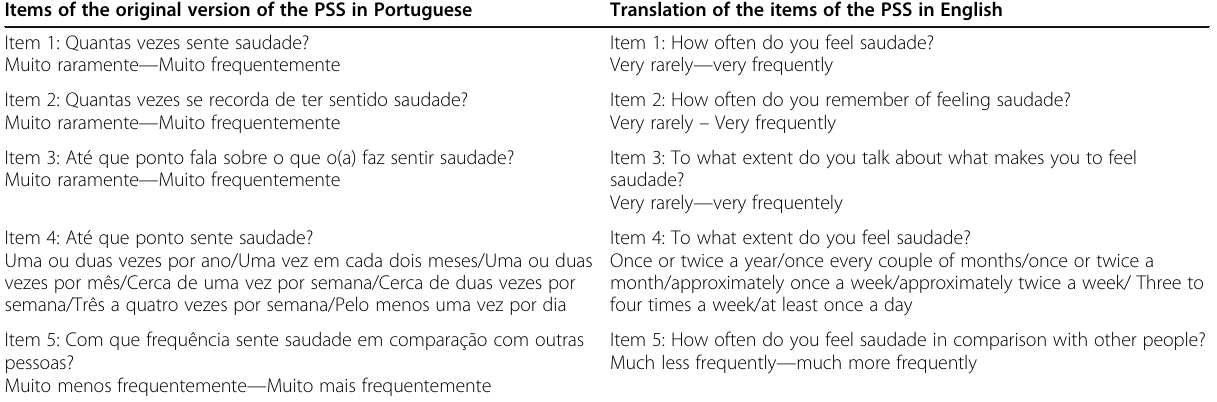
Table 1 Original version in Portuguese and English translation for the Porto Saudade Scale Items of the original version of the PSS in Portuguese Translation of the items of the PSS in English